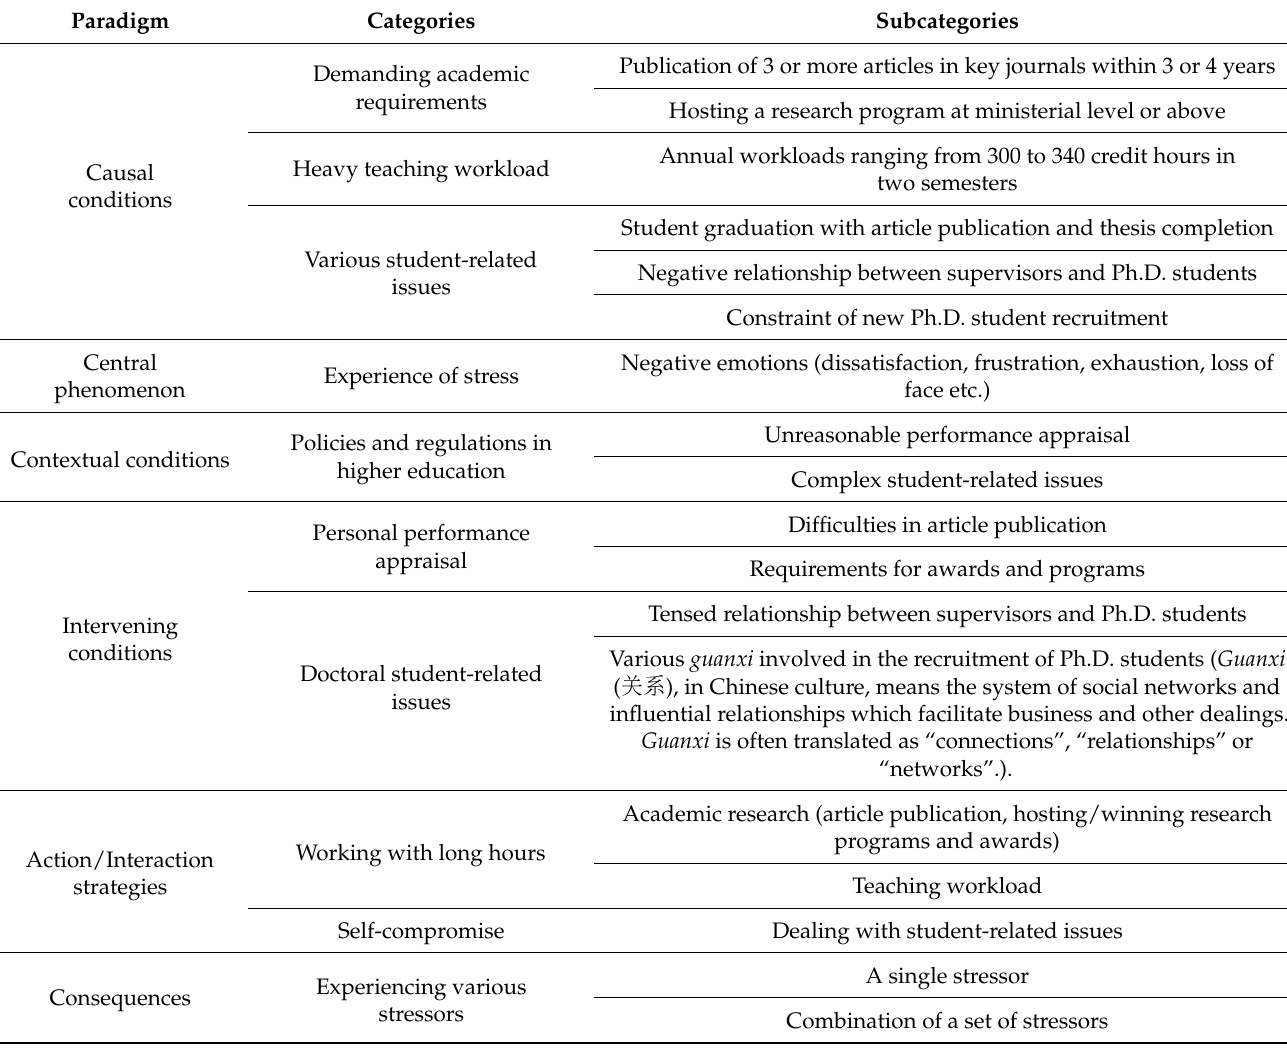
Table 2. Coding of identified occupational stress suffered by Chinese doctoral